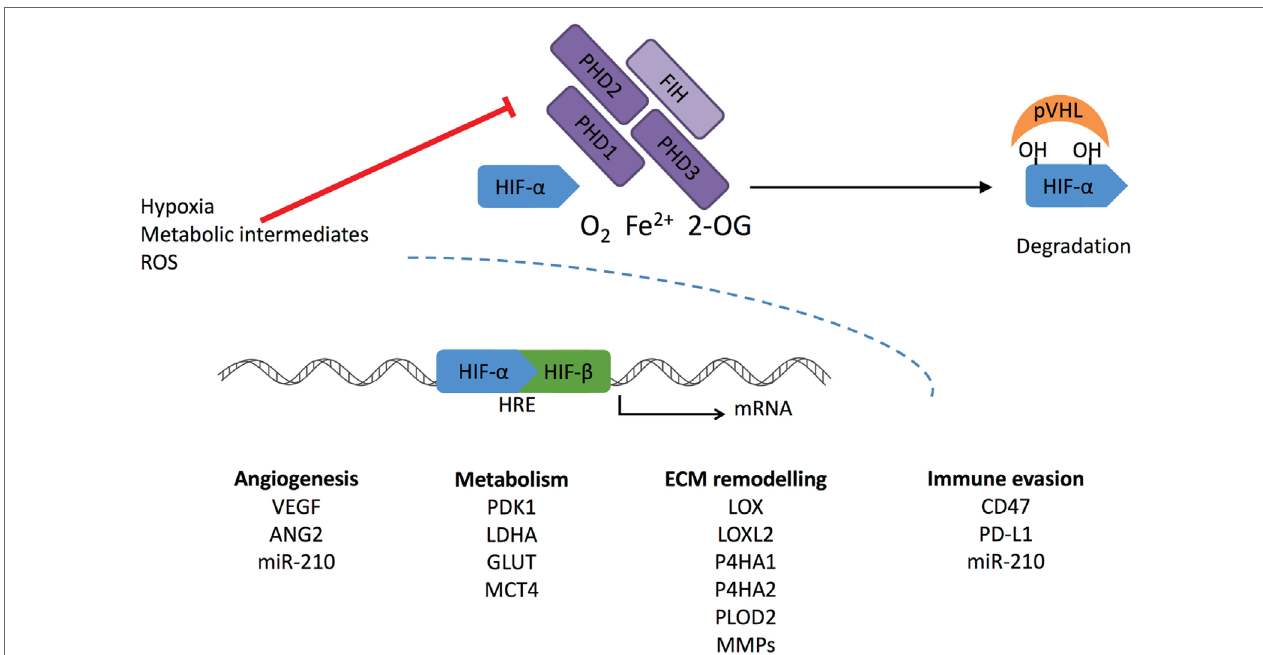
FiGURe 1 | Regulation of HIF- α stabilization. Cellular oxygen levels are sensed by HIF prolyl hydroxylase (PHD) 1–3. They hydroxylate two specific proline residues in the HIF- α subunit, which require O 2 , Fe 2 + , and 2-oxoglutarate (2-OG). 4-Hydroxyprolines are recognized by von Hippel-Lindau (pVHL) complex that ubiquitylates HIF- α causing its proteasomal degradation. Another member of the dioxygenase superfamily, factor-inhibiting HIF (FIH), hydroxylates one asparaginyl residue at the transcriptional domain of HIF causing suppression of the transcriptional activity. Under hypoxic conditions, PHD and FIH activity is inhibited, and unhydroxylated HIF- α forms a complex with HIF- β and activates transcription of HIF target genes. Reactive oxygen species (ROS) and intracellular metabolites can inhibit PHDs and FIH-stimulating transcriptional activation of HIF-1 α , leading to increased expression under normoxic